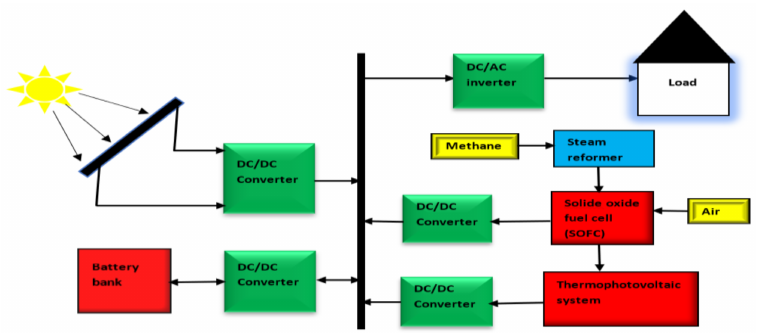
Figure 5. Block diagram of an IPVFC system including SOFC and TPV